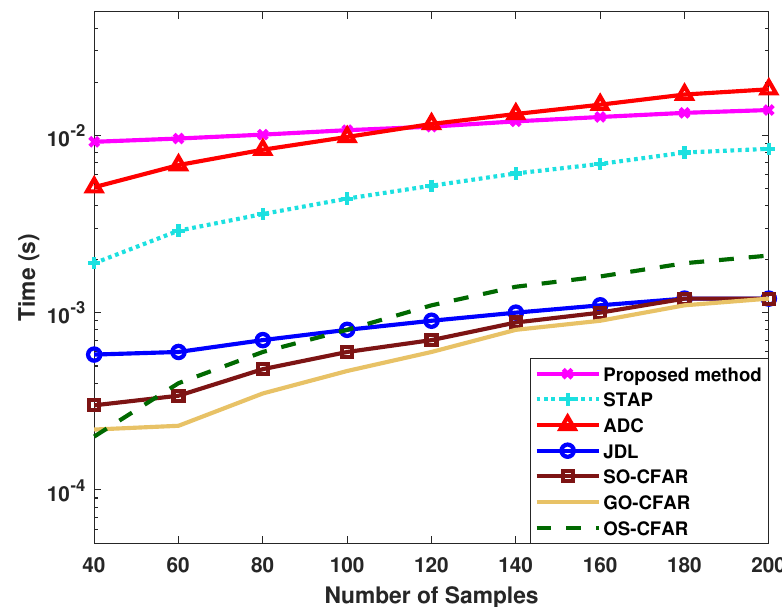
Figure 11. Relationship between computation time and number of